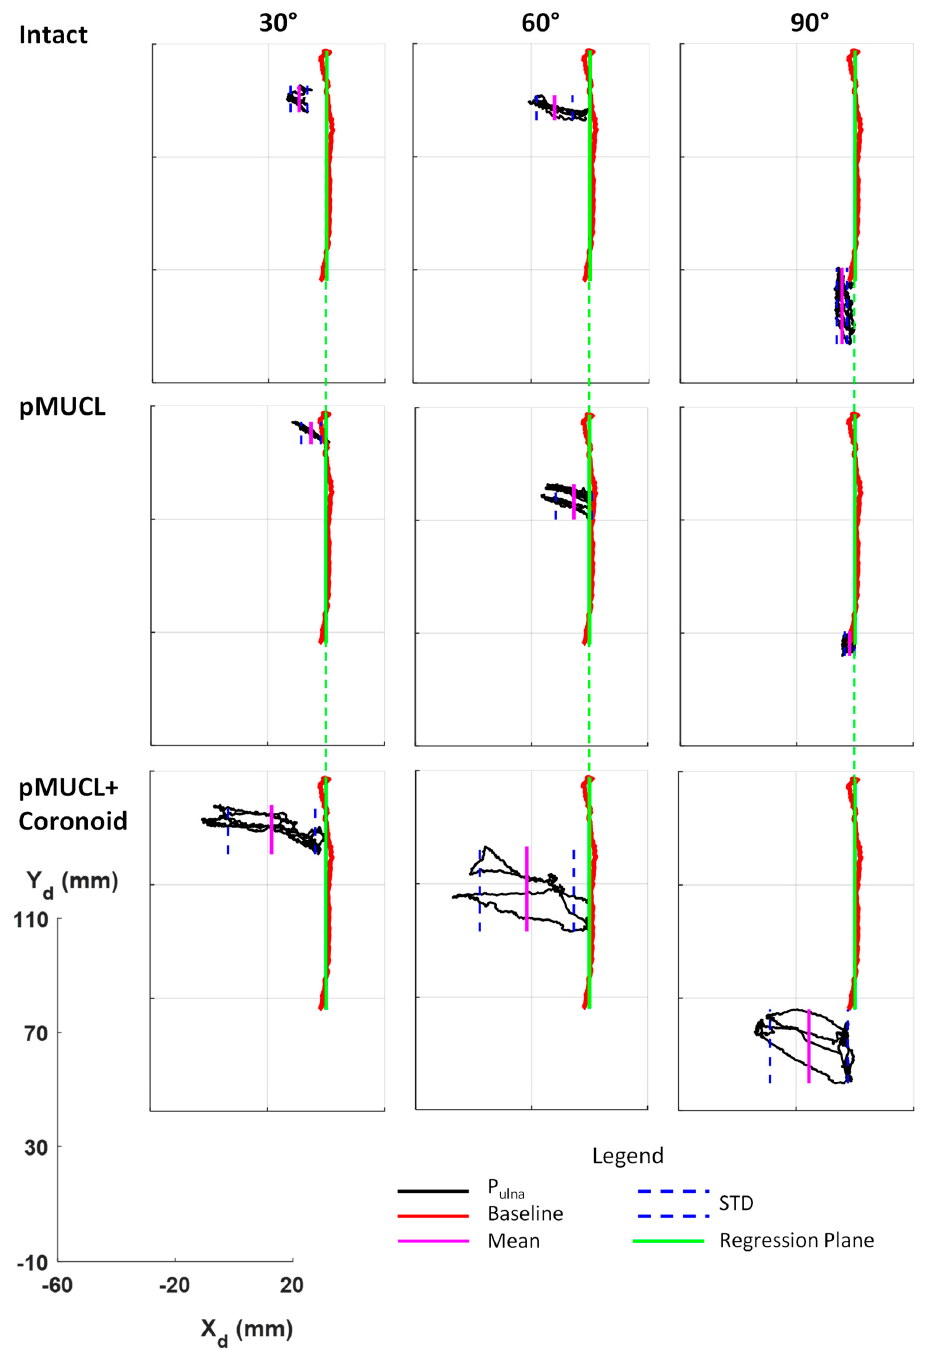
Figure 4. Elbow_1 stability for different surgical (intact, pMUCL section and pMUCL section + coronoid osteotomy) and biomechanical (static flexion of 30°, 60°, 90°) conditions are reported. The red line depicts the baseline trajectory of physiological elbow flexion–extension motion with an intact elbow and the green line represents the regression plane. The black line depicts the P Ulna trajectory during the orthopedic maneuver with mean and STD values highlighted as pink and blue lines, respectively. A common reference axis is reported to describe the measures of deflection (mm).